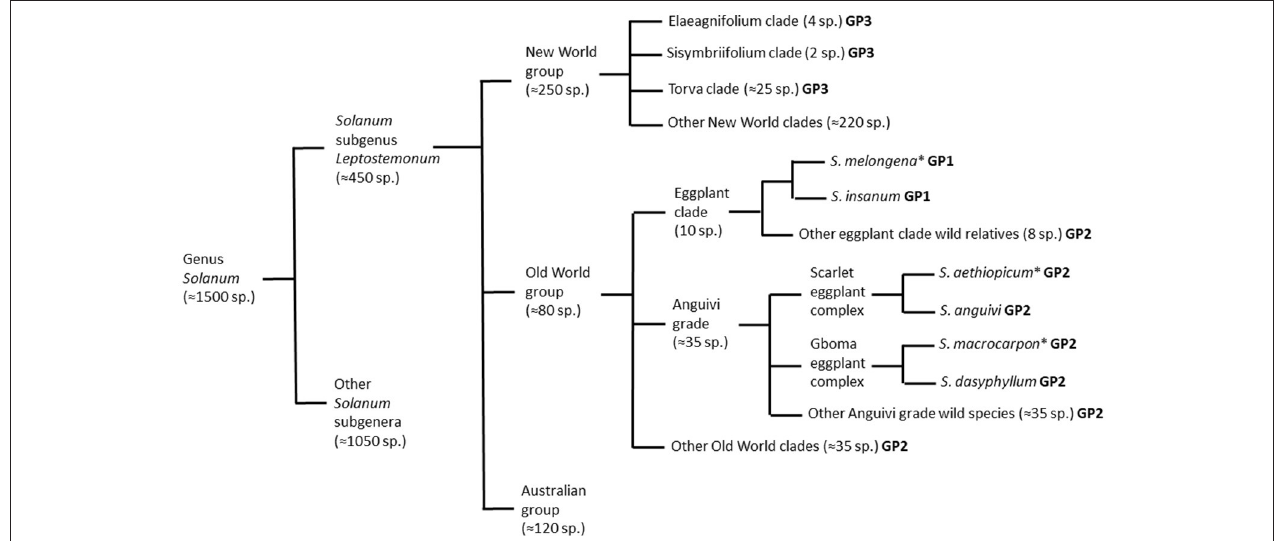
FIGURE 1 | Schematic representation of taxonomic relationships between the cultivated brinjal eggplant ( Solanum melongena ) and other cultivated (scarlet eggplant, S. aethiopicum ; and gboma eggplant, S. macrocarpon ) and wild relatives from the genus Solanum based on Nee (1999), Levin et al. (2006), Weese and Bohs (2010), Stern et al. (2011), Knapp et al. (2013), Syfert et al. (2016), and Vorontsova and Knapp (2016). For each of the species and groups it is indicated if they are part of the primary (GP1), secondary (GP2), or tertiary (GP3) brinjal eggplant genepools. The three cultivated species are indicated with an asterisk.